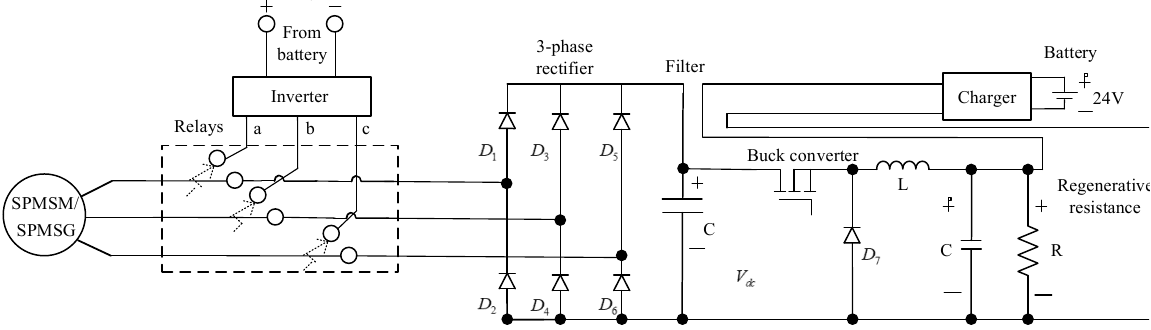
Figure 8. Implemented regeneration circuit of the PMSM drive system. Figure 9a is a photograph of the SPMSM, including the stator, rotor, and air gap. The